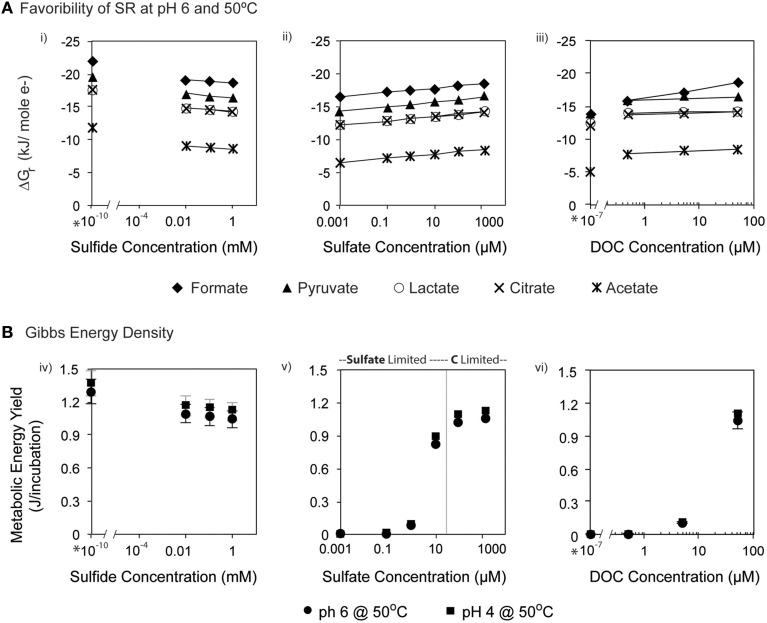
(A) ΔGr (kJ/mol e−) calculated at pH 6 and 50°C for heterotrophic sulfate reduction via organic acids (formate, acetate, pyruvate, lactate and citrate) at varying concentrations of (i) sulfide, (ii) sulfate, and (iii) DOC. (B) The total energy available for sulfate reduction in each incubation at 50°C. Bars on each symbol represent the range of values for 4°C and 90°C. Asterisks (*) denote contrived values of zero that were inputted into the model for speciation calculation in EQ3.